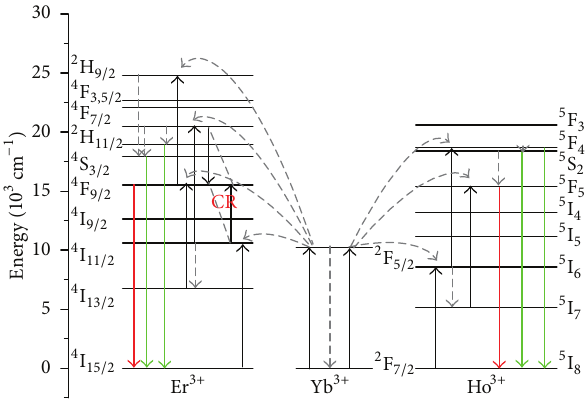
Figure 4: Schematic energy level diagrams of Yb 3+ , Er 3+ , and Ho 3+ ions and proposed upconversion